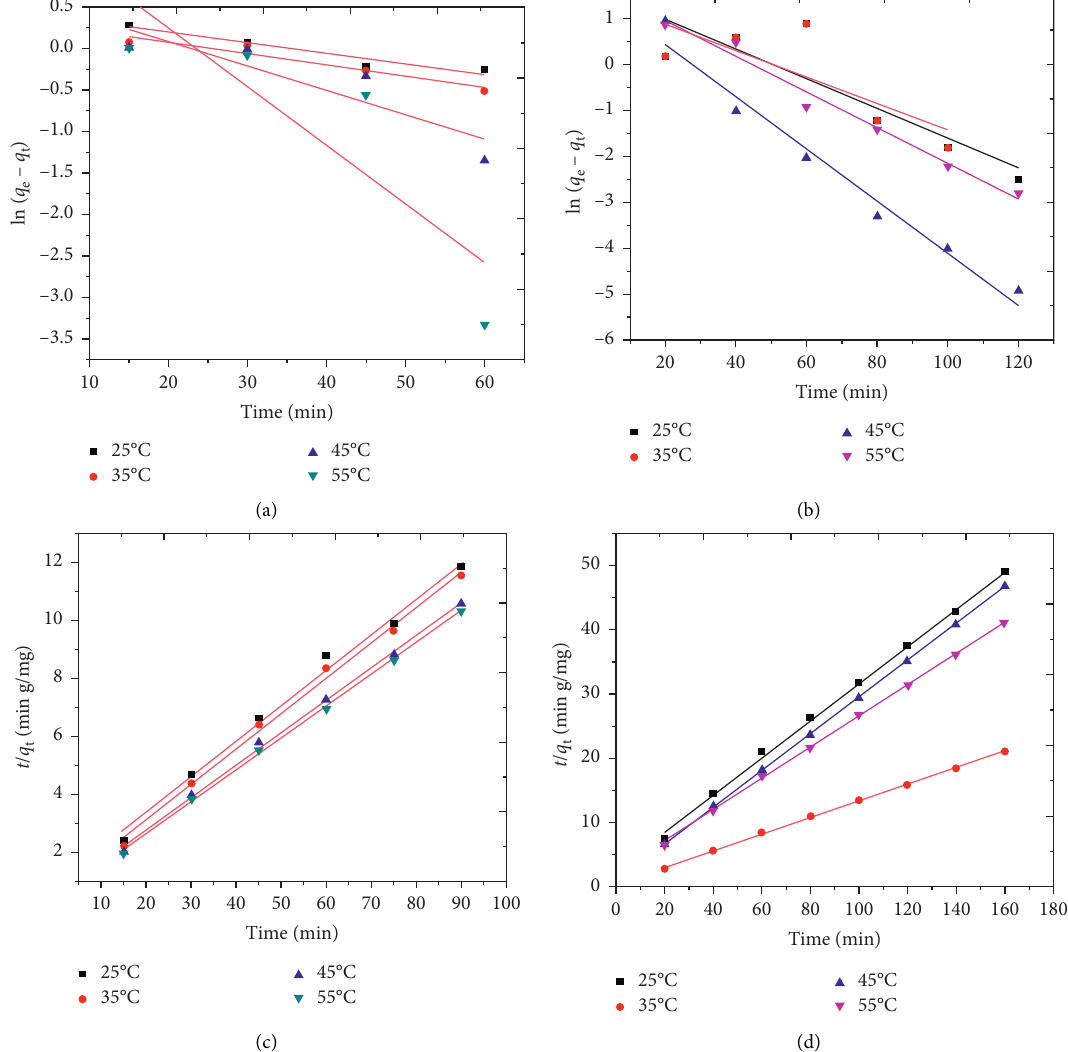
Figure 7: Pseudo-first-order kinetics of (a) CR and (c) SF; pseudo-second-order kinetics of (b) CR and (d) SF.